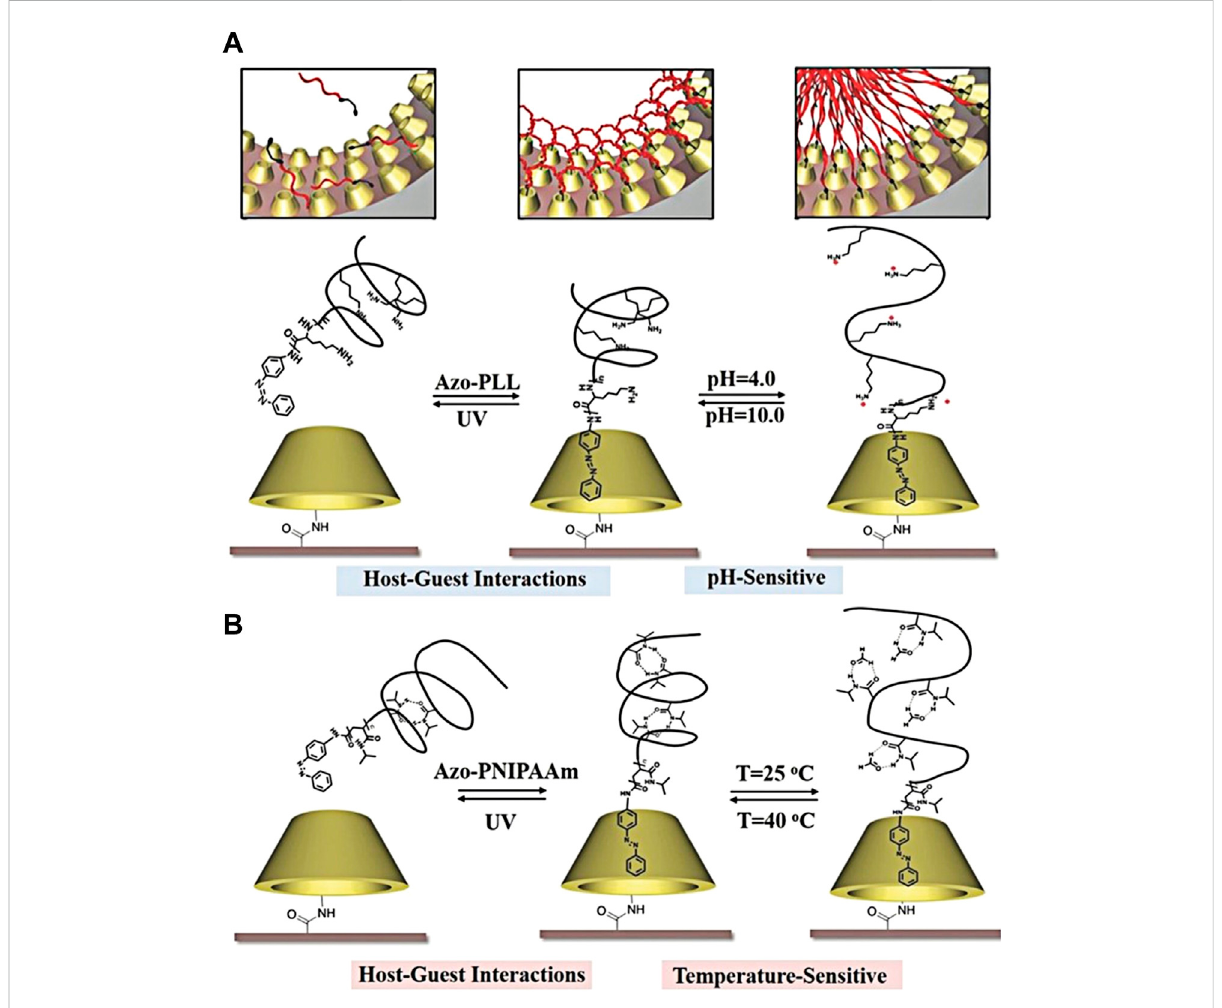
FIGURE 3 (A) Schematic diagram for the reversible assembly of poly-L-lysine-derived azobenzenes assembled in α -CD-modi fi ed nanochannels through the host – guest interaction with light- and pH-responsive properties; (B) schematic diagram for the reversible assembly of